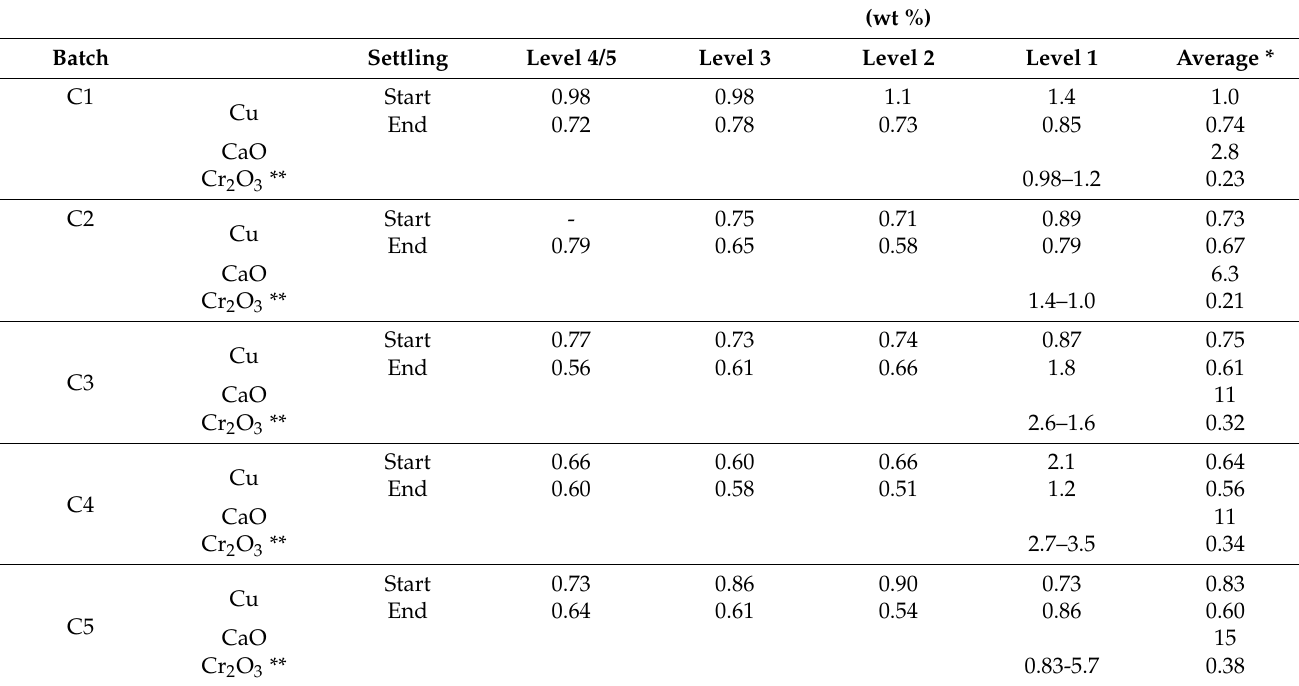
Table 4. Copper content at the settling start and end in vertical slag samples from C1–C5, and the average Cu, CaO, and Cr 2 O 3 content based on levels 5/4, 3, and 2.